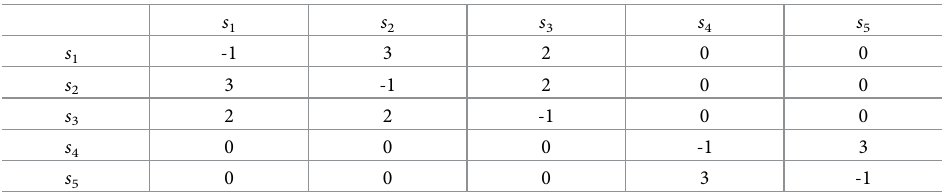
Table 2. Matrix A for posets in Fig